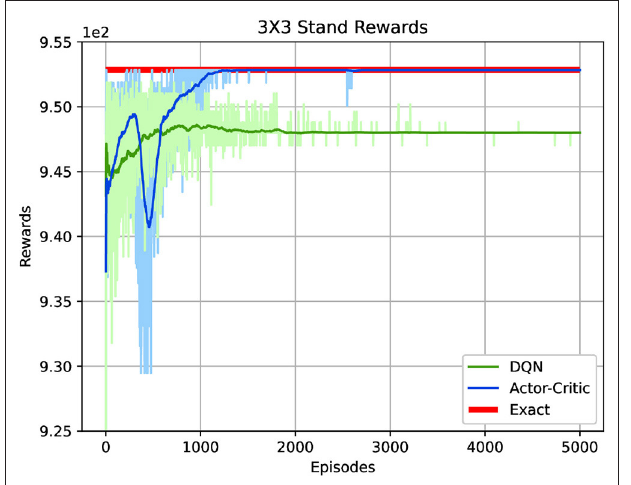
FIGURE 7 | Obtained DRL solution for the 10 with the GA obtained value.